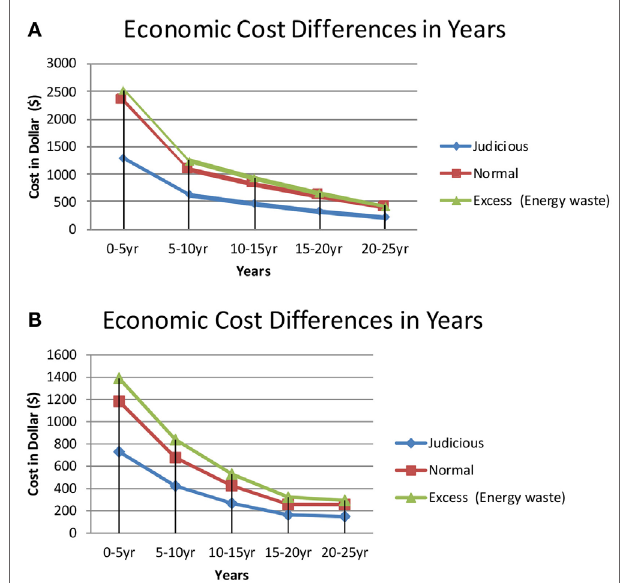
FigUre 9 | economic cost difference in 5 years intervals for different pattern of load consumptions for energy efficient lightings with (a) PV/surrette battery system configuration, and (B) PV/hoppecke battery system configuration